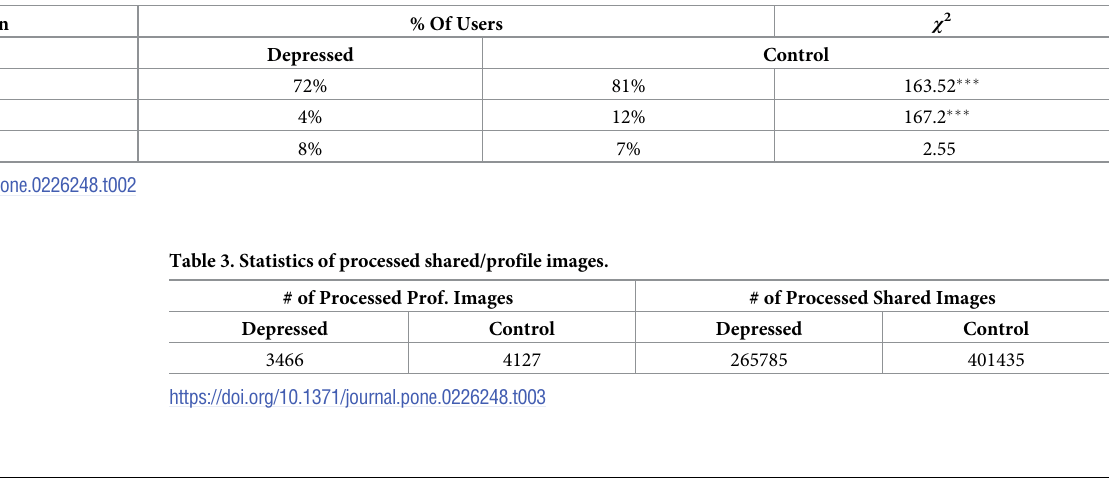
Table 2. Facial presence comparison in profile/posted images for depressed and control users— ��� alpha = 0.05.